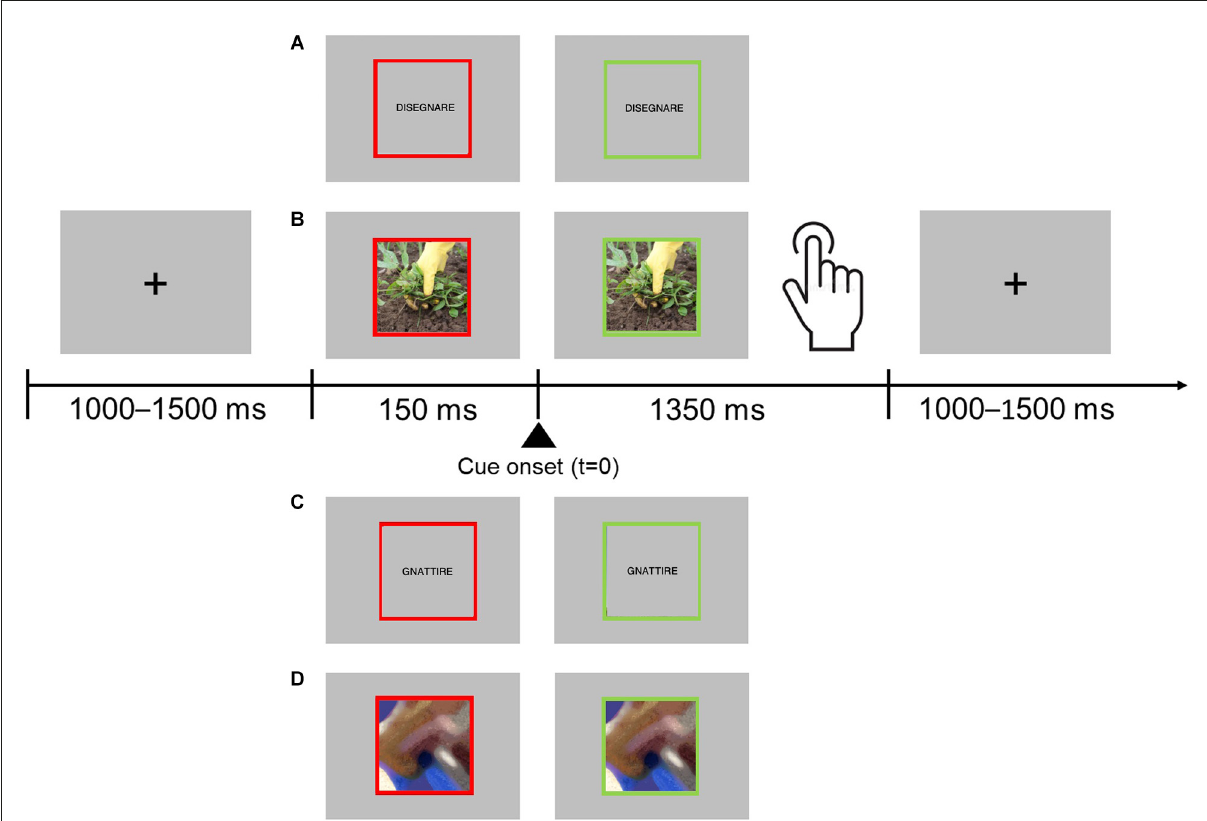
FIGURE1 Experimental procedure. Participants were asked to fixate on the center of the screen placed in front of them. Each trial started with the presentation of the stimulus surrounded by a red frame. The stimulus could be either a hand or foot verb, a hand or foot action image, and a pseudoverb or a scrambled image. After 150 ms the frame turned green, and the participants were allowed to respond. Participants were instructed to respond only to words and pictures depicting hand- or foot-related actions. The trial ended when participants provided their responses or after 1,350 ms if no response was given. Stimuli examples: hand action verb (A) , hand action image (B) , pseudoverb (C) , scrambled image (D)